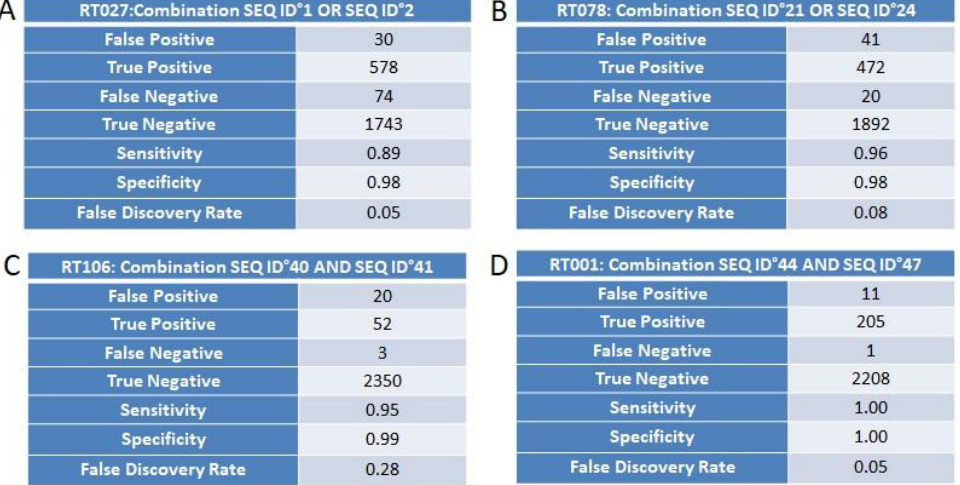
Figure 4. ( A – D ) Statistical reliability in terms of sensitivity, specificity, and false discovery rate (FDR) for the combination of two selected markers using OR operator for the identification of C. difficile RT027 (Panel A ) and RT078 (Panel B ). Panels C and D display similar analyses but then using the AND operator for identification of RT106 and RT001, respectively.